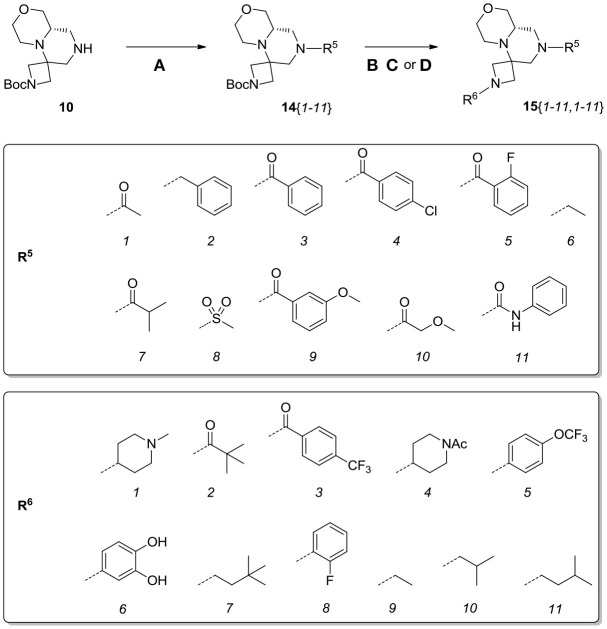
Synthesis of library 15. Reagents and conditions: (A) acyl chloride (or sulfonyl chloride or isocyanate), Et3N, DCM, rt; (B) acyl chloride or sulfonyl chloride, Et3N, DCM or (C) isocyanate, DCM or (D) aldehyde/ketone, borane-Me2S complex, DCM.